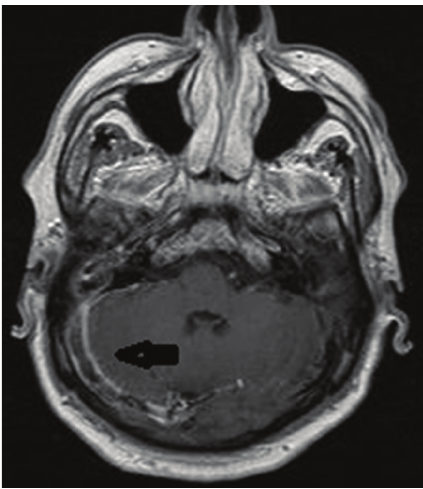
Figure 4: Axial brain MRI with contrast showed filling defects in right sigmoid and transverse